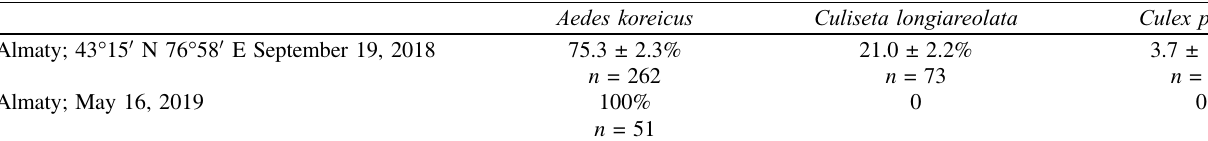
Table 1. Ratio of species in the collected samples of mosquito larvae.